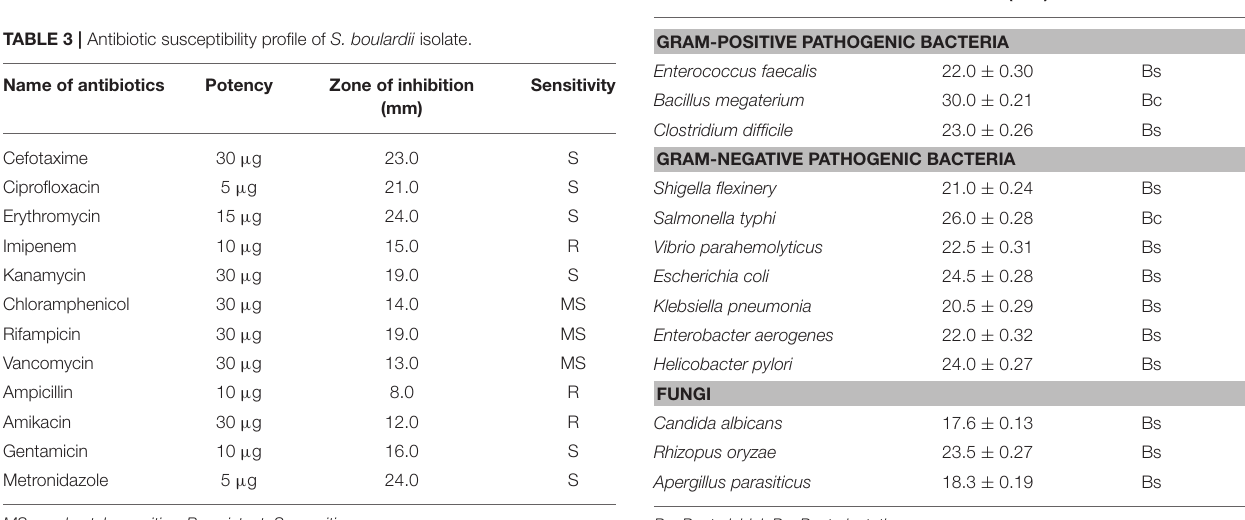
FIGURE 3 | In-vitro gastrointestinal digestion effect on the growth of S. boulardii .